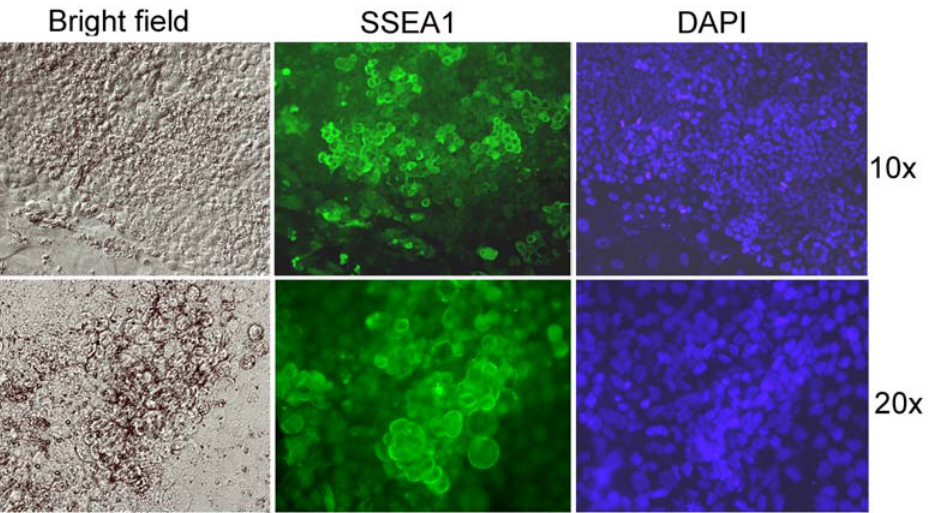
Figure 5. Continued proliferation and preferential accumulation of SSEA1-positive cells in old rat colonies derived from rat XEN-P cells. Two magnifications of a representative 16-days old colony (line RX1) are shown. Bright field (left), immunofluorescence (middle), and nuclear stain (right). Control omitting primary antibody was negative and is not shown.